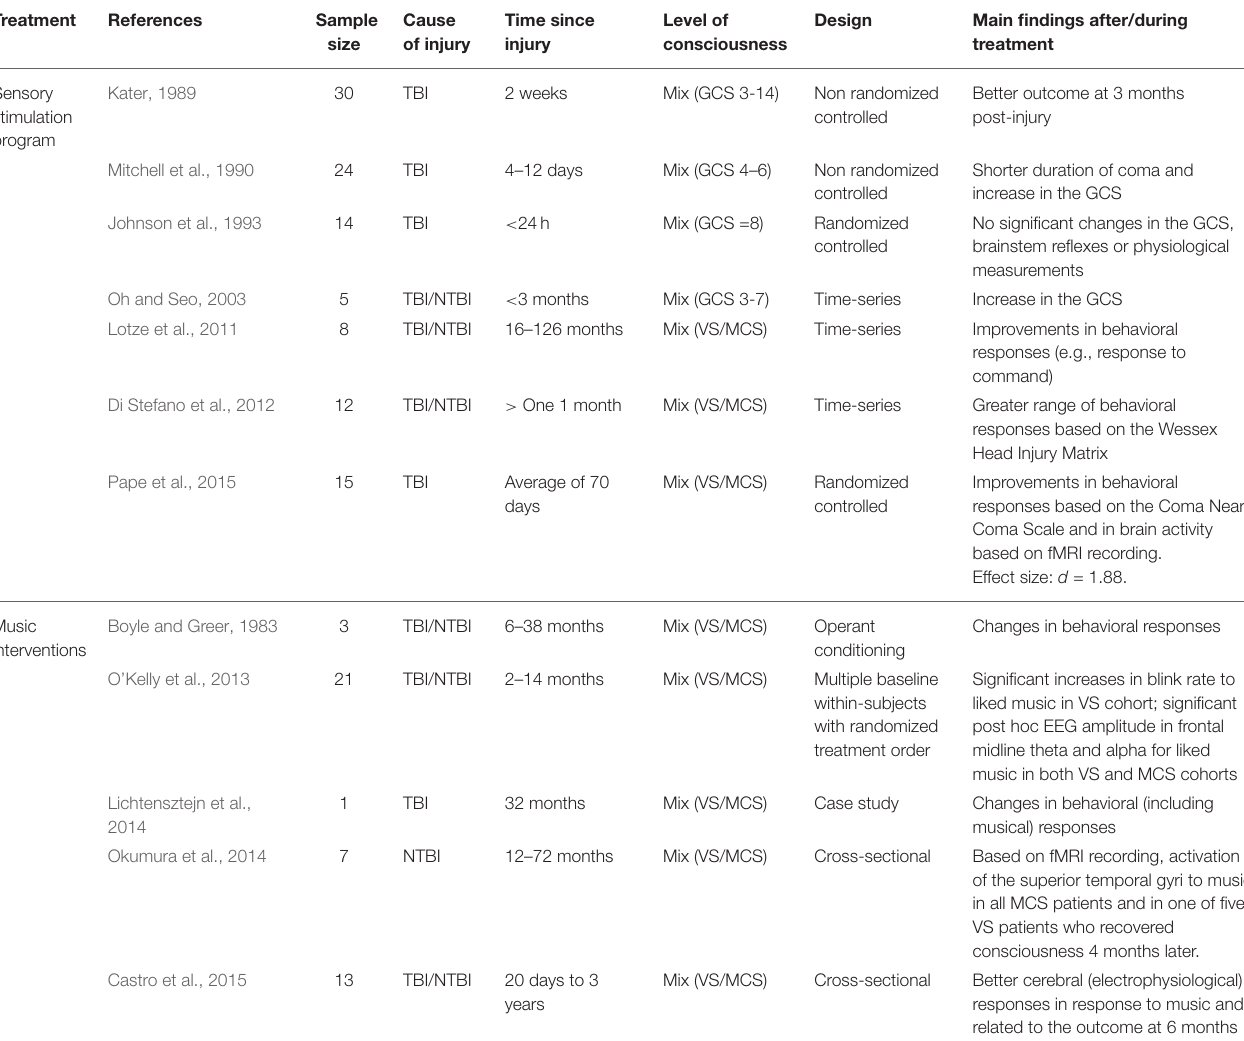
TABLE A1 | Summary of previous studies investigating sensory stimulation program and music